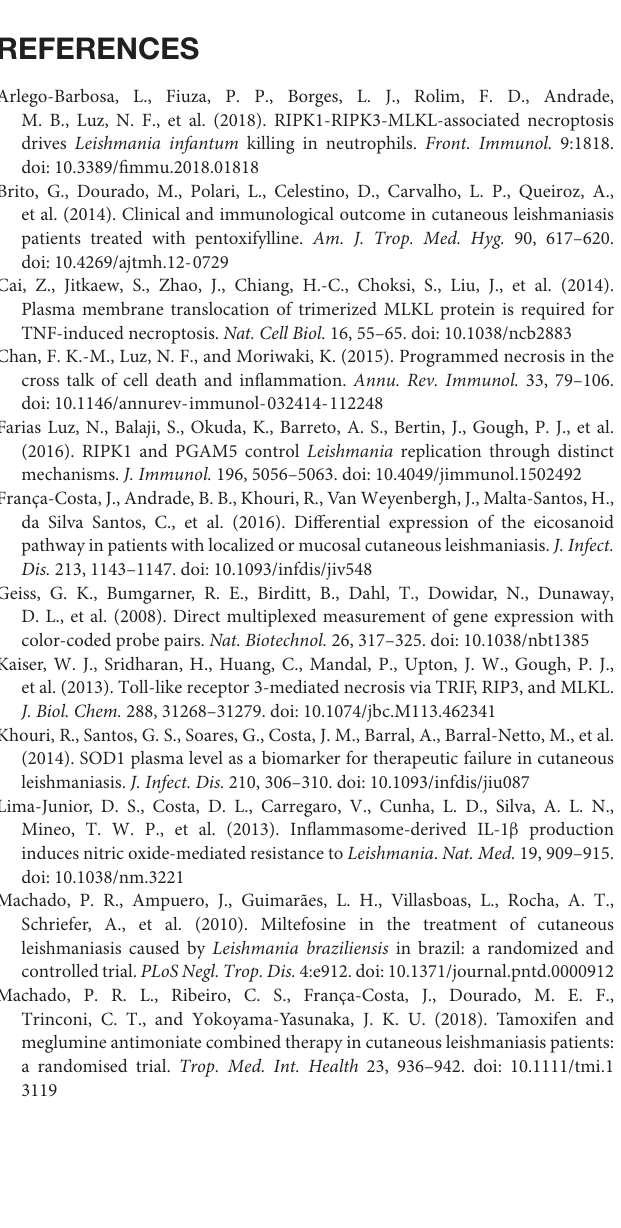
FIGURE S2 | Correlation between the inflammatory cell infiltration score values and CD45 and CD14 expression levels in skin lesions from patients with LCL. Total mRNA was extracted from lesion biopsy specimens obtained from six patients with localized cutaneous leishmaniasis (LCL), indicated mRNA transcripts of genes CD45 (A) and CD14 (B) were quantified by nCounter (NanoString). (C) Pearson correlation analysis between CD14 and CD45. A pathologist examined the cellular infiltration in microscopy as explained in the “Patients and Methods” section. Linear curve fit with 95% confidence interval were used to illustrate distribution of the data.